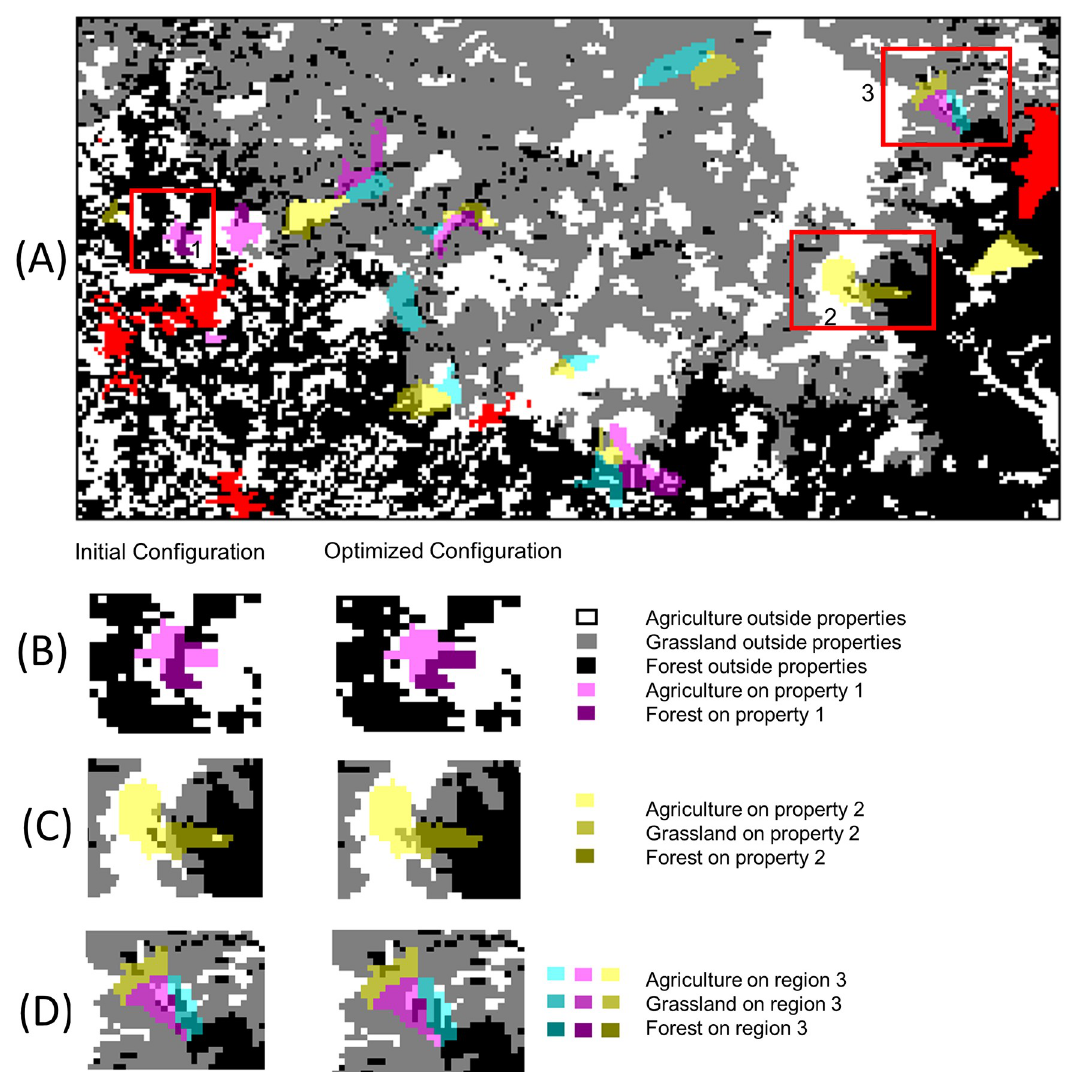
Fig 9. Case study results. (A) Vegetation states of all the parcels on the case study landscape before the algorithm was applied (initial landscape). White parcels are agricultural land, gray parcels are grassland, and the black parcels are forest land. Red parcels are urban and water parcels. The other colors (magenta, cyan, and yellow) overlaid on the map represent the landowner properties ( > 50 ha in area) that have been registered through INCRA as of November 2015. (B)-(D) Optimal configuration for three highlighted landowner properties on the case study